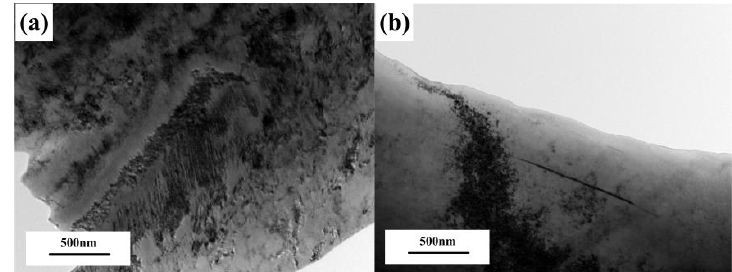
Figure 8. TEM micrograph of the samples deformed at 1050 °C and different strains of ( a ) 0.2 and ( b ) 0.5.